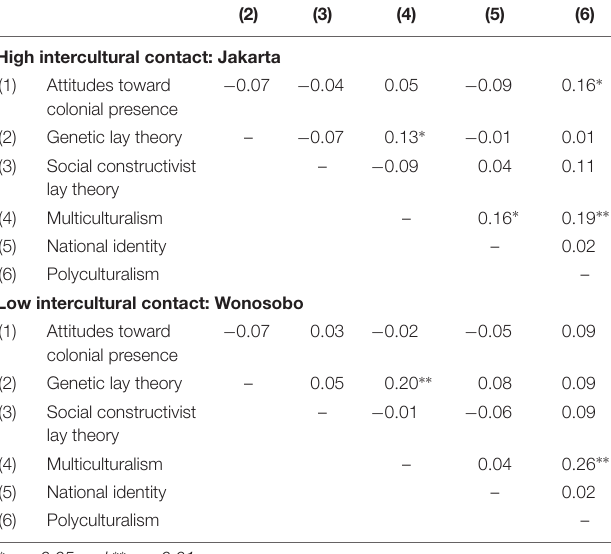
TABLE 5 | Correlations among key variables for two Indonesian samples.